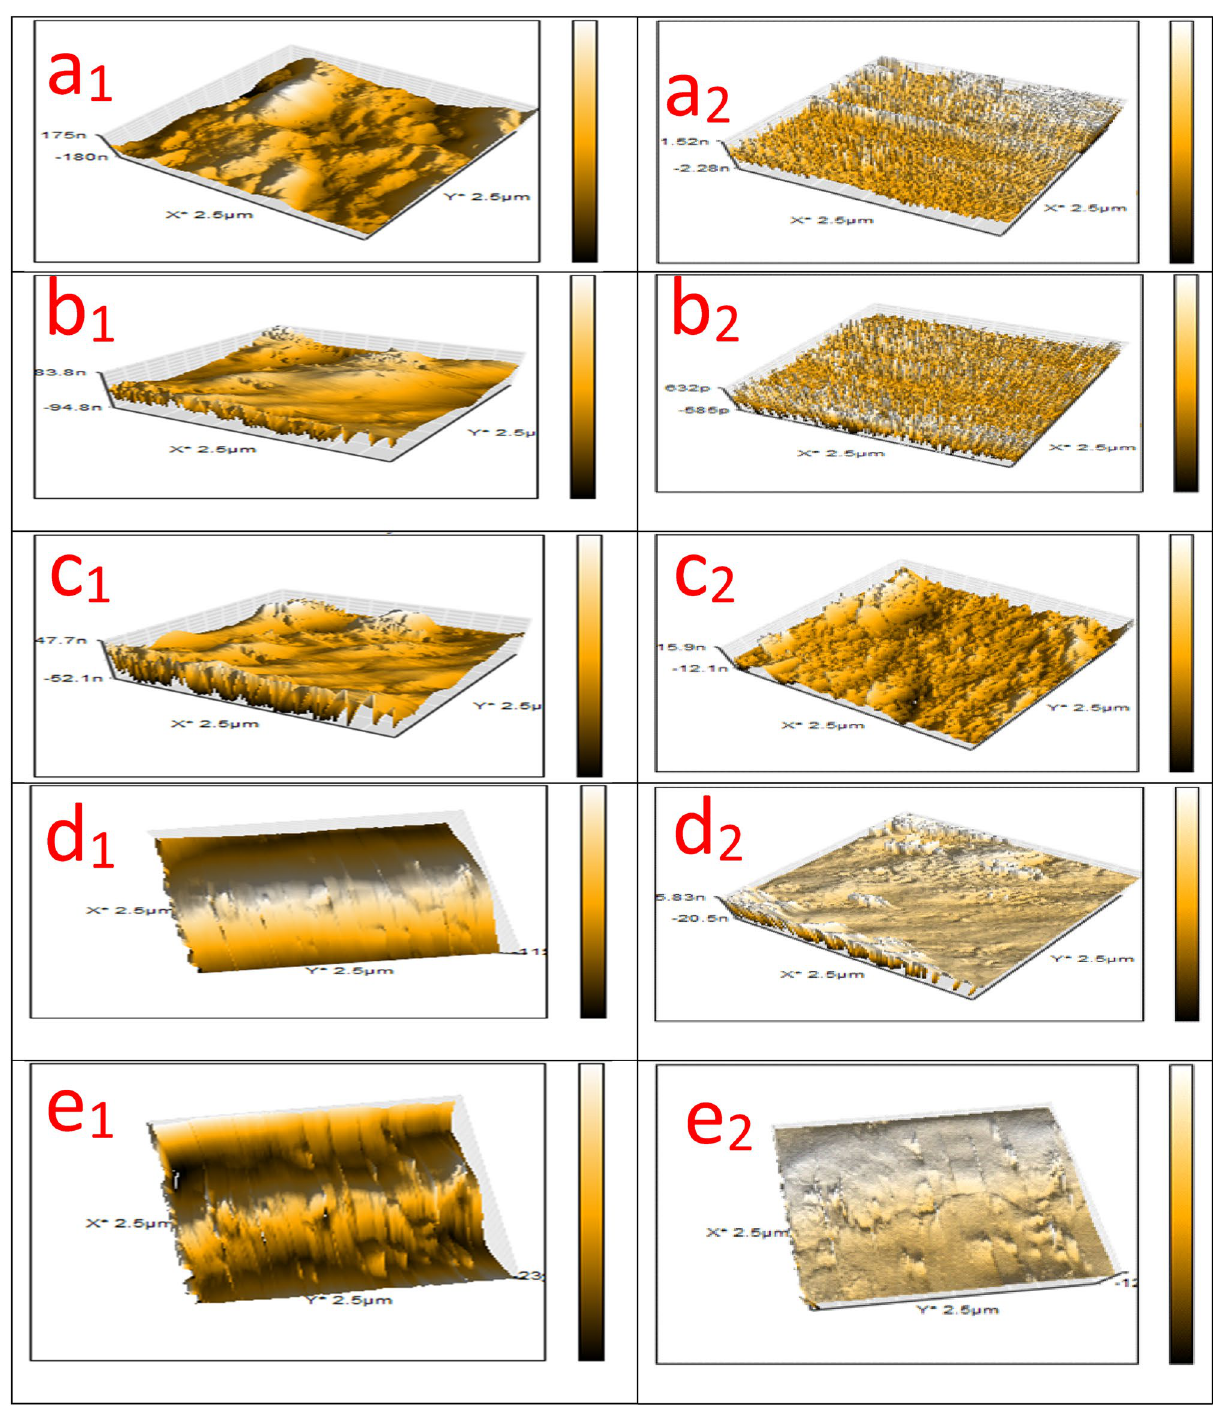
Figure 14. AFM diagrams of the investigated coated films ( a 1 , a 2 ) Unmodified conventional epoxy, ( b 1 , b 2 ) PA-DGEBA/MF, (